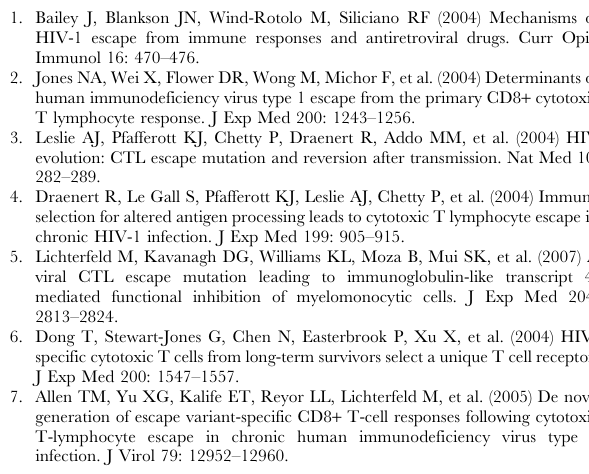
Figure S2 Binding of A11-AK11 wild-type tetramer and the corresponding variant tetramer (AK11 G9S) to HIV- 1-specific CD8 T cells. Dot plots indicate binding of the wild type and the respective variant tetramer to wild-type-specific CD8 T cells in the presence or absence of ILT4 blocking antibodies.